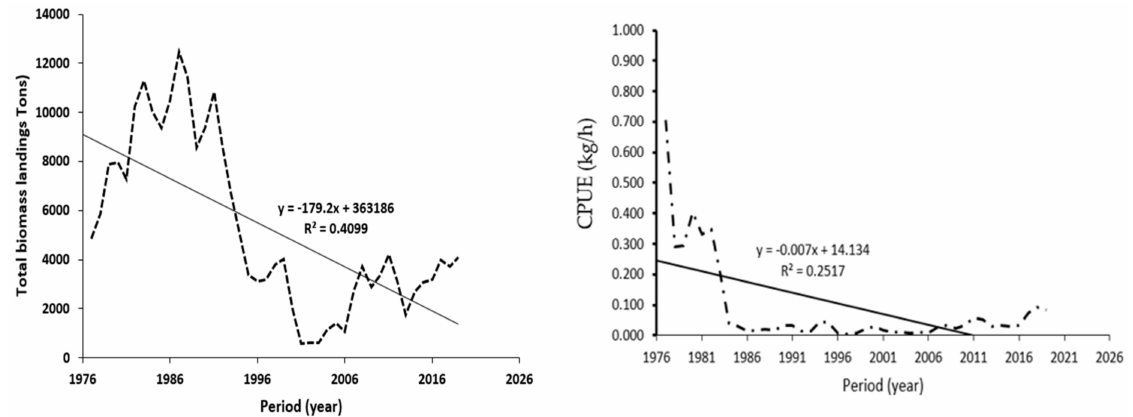
Figure 9. Biomass and CPUE